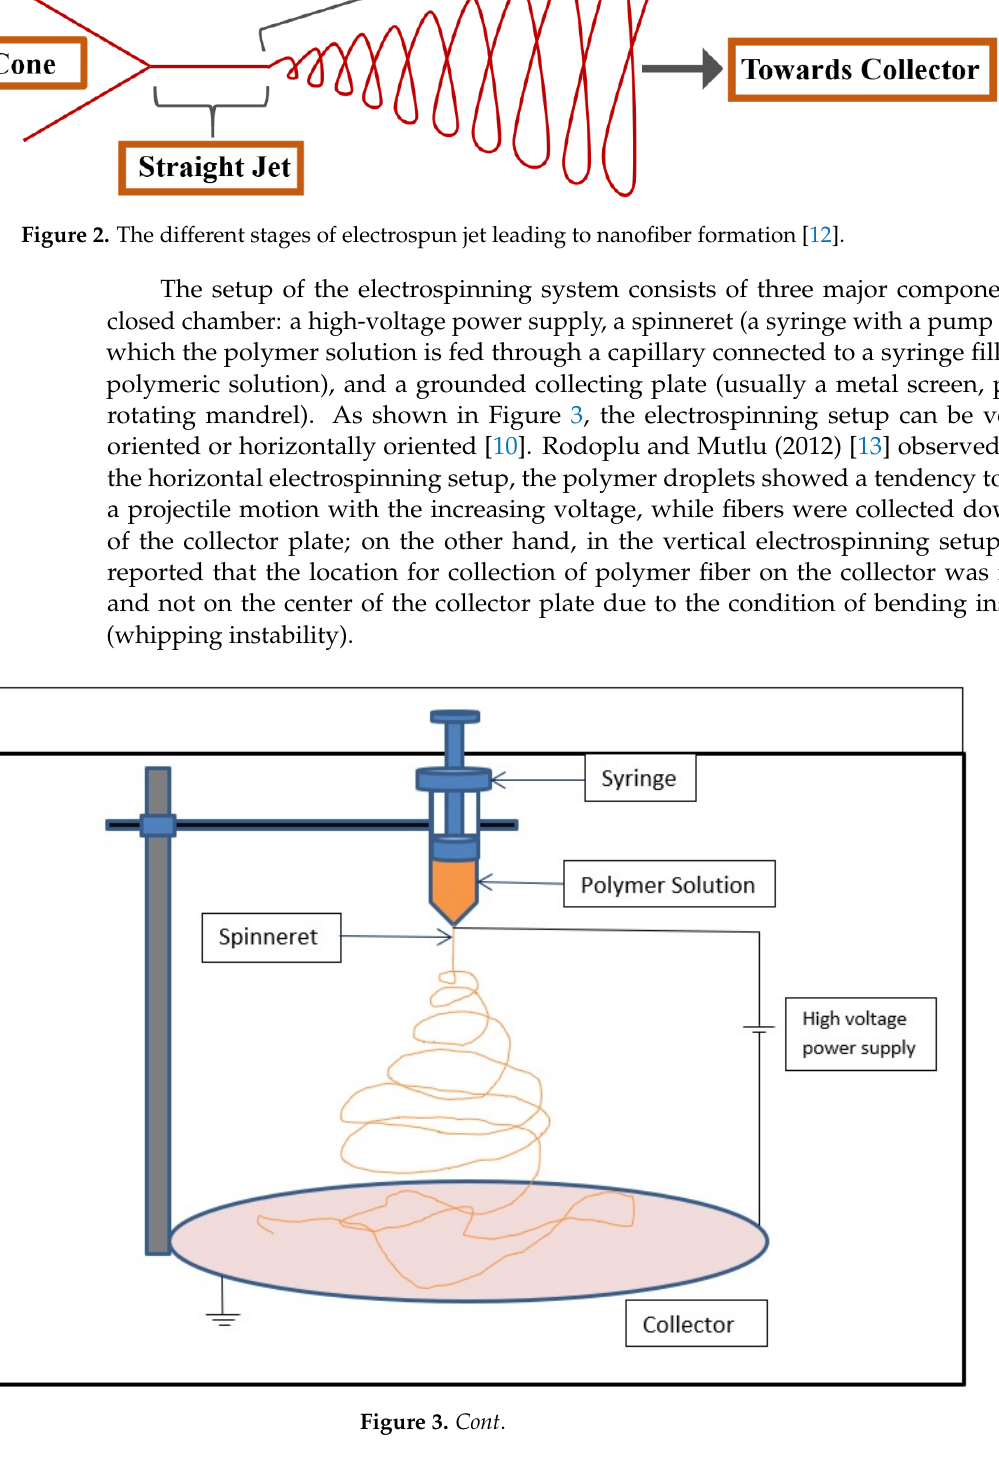
Figure 3. The vertical and horizontal orientations of the electrospinning setup [10]. 2.1. Effect of electrospinning parameters on nanofiber properties The nanofiber morphology and size are greatly determined by the feed polymeric solution parameters (concentration, molecular weight, solvent, viscosity, conductivity, surface tension, and the addition of polyelectrolyte) and electrospinning process parame- ters (applied voltage, tip to collector distance, and flow rate) [14]. Different nanofibers with different morphologies, structures, and arrangements can be created by understand- ing these parameters and varying them.